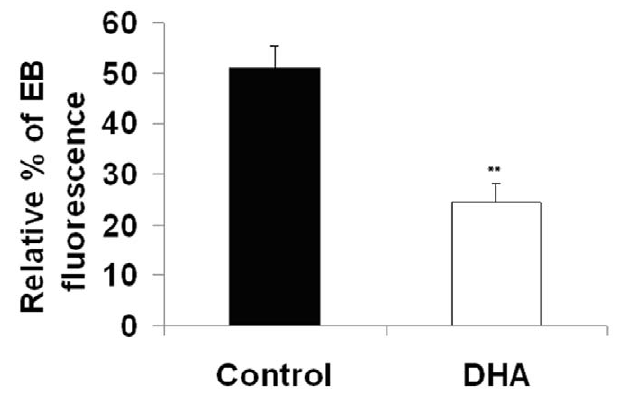
Figure 5. DHA impairs oxidative metabolism in infected J774A.1 cells under IFN c treatment. Cells were incubated with 50uM DHA for 24 h and infected with 20 MOI of Mtb . Reactive oxygen intermediates were estimated by FACS, as described in the Materials and Methods . a. Quantitative data show the relative percentage of EB red fluorescence (mean 6 SEM; n=9). * Indicates a significant effect of DHA compared to Control, **p , 0.01. Abbreviations used: DHA, docosahexaenoic acid; EB, ethydium bromide.